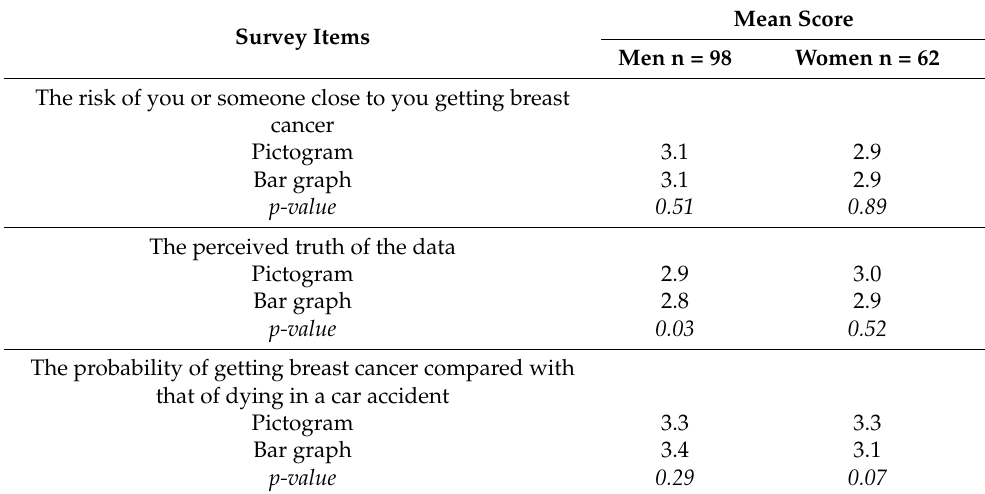
Table 3. Differences in risk perception and data reliability depending on data presentation style: stratified by